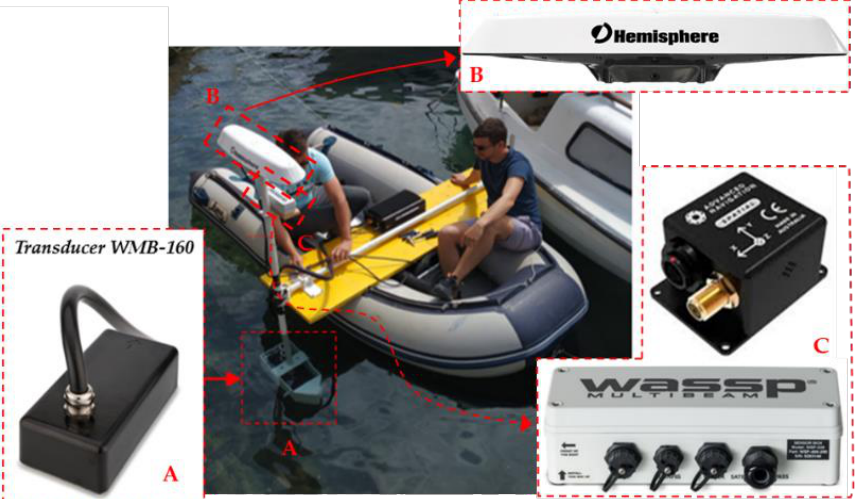
Figure 6. ( A ) The WMB-160 transducer, ( C ) the WASSP sensor box with integrated advanced navigation spatial IMU WSP002-INU and the ( B ) Hemisphere V320 GNSS Smart Antenna. Table 2. The GNSS sensor specifications.